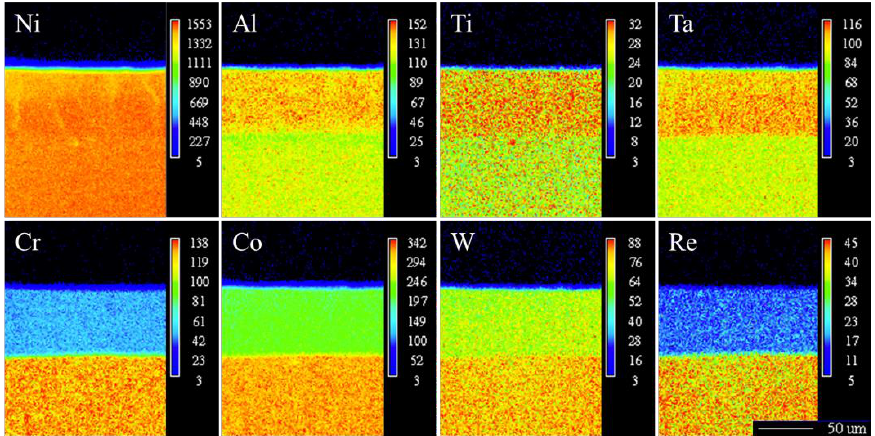
Figure 5. EPMA mappings on the cross-section of the γ’-phase layer. (The colour scale on the right side indicates the elemental concentrations.)